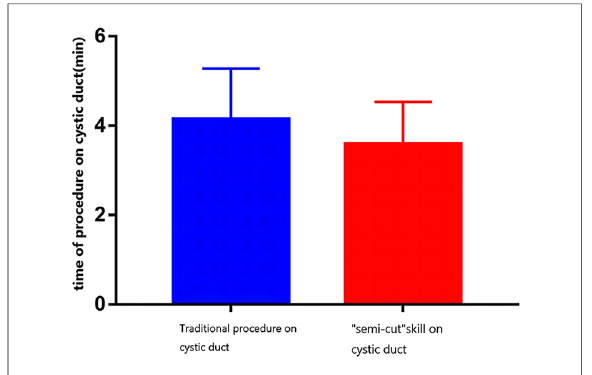
FIGURE 1 Comparison of the surgical time between the two procedures. No signi fi cant difference was found between the two groups.